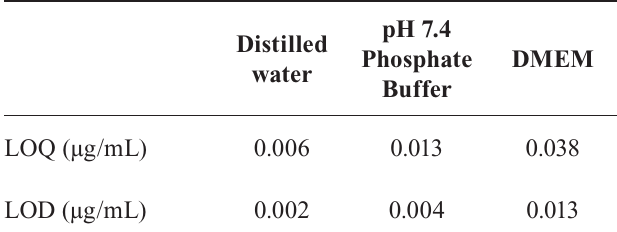
TABLE IX - Limit of detection and limit of quantitation values for dexketoprofen